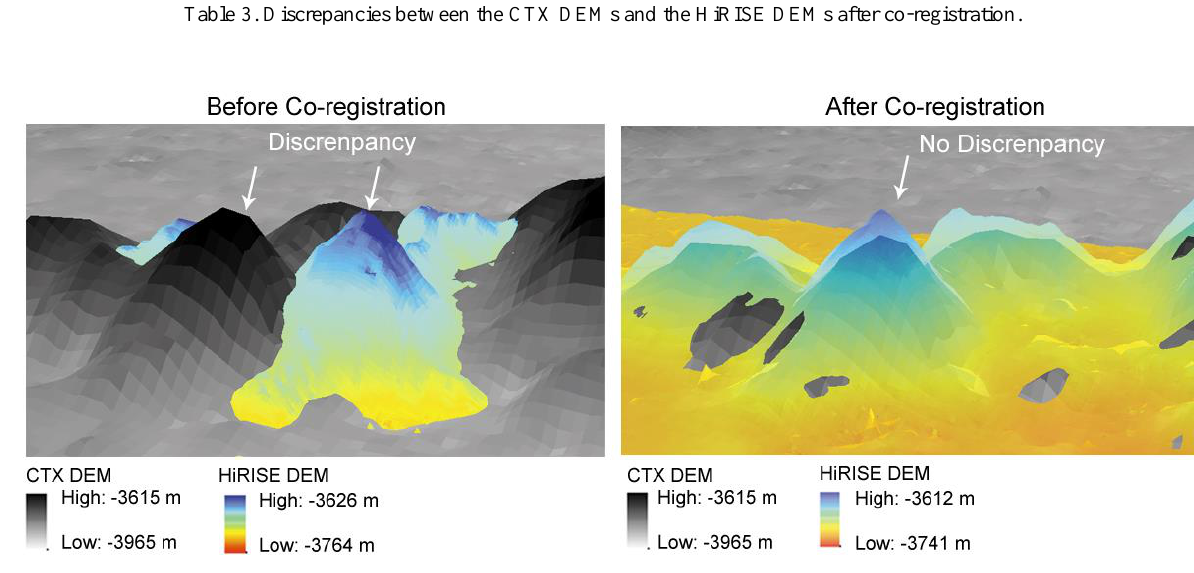
Figure 5. Comparison of HiRISE and CTX DEMs in 3D view. Left shows the 3D view of the DEMs before co-registration and right shows the 3D view after